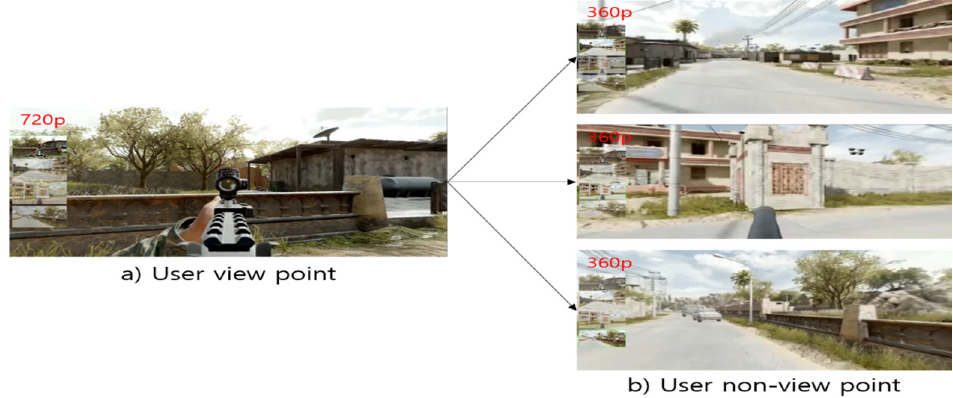
Figure 19. ( a ) Game user viewpoint (360 degrees). ( b ) User non-viewpoint screen.